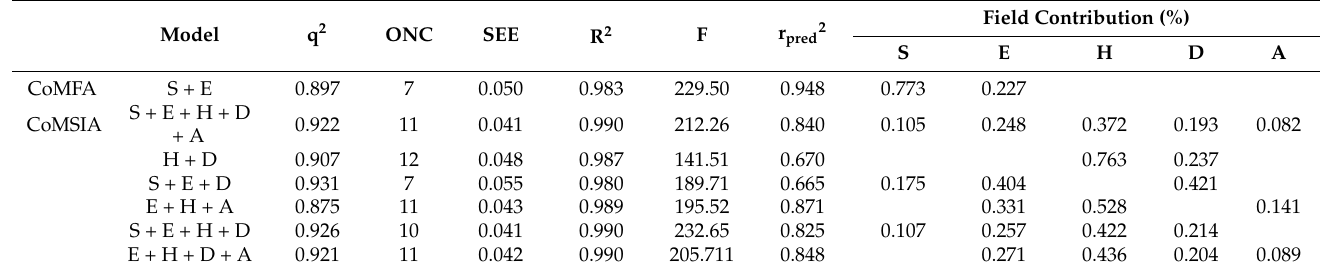
Table 2. Internal statistical parameters of the CoMFA and CoMSIA models.